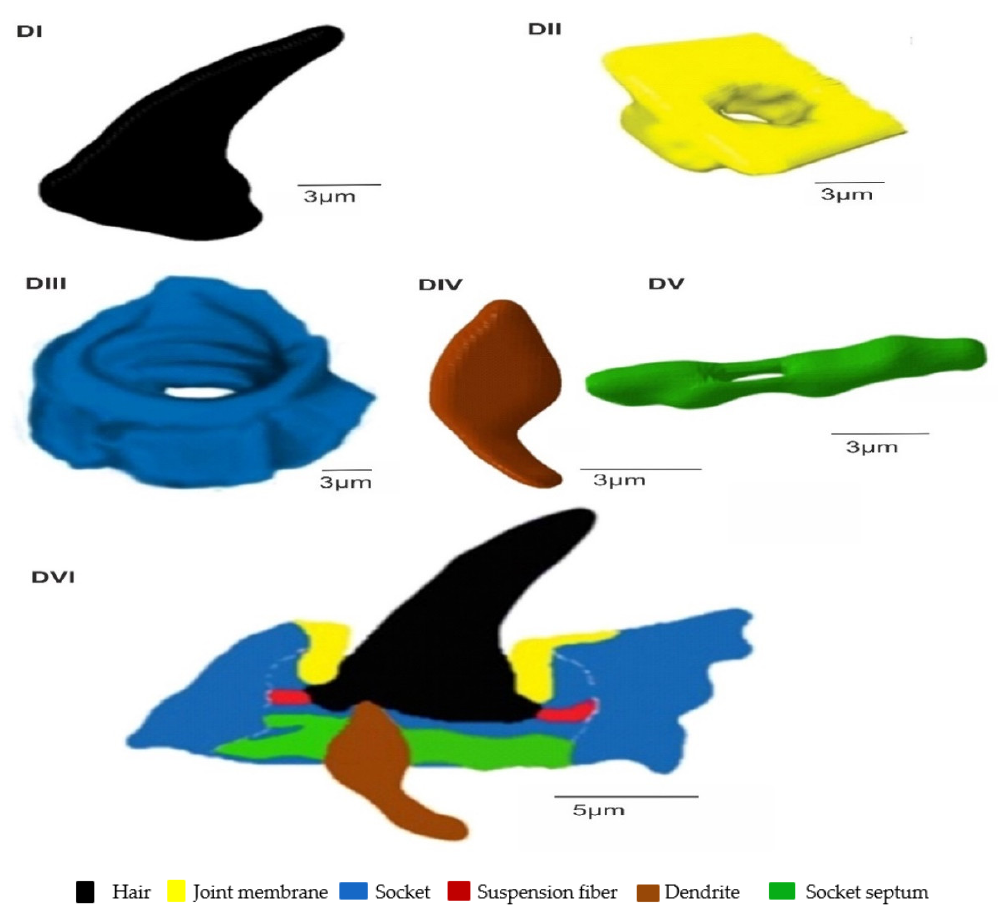
Figure 8. Three-dimensional model of trichoideum sensillum’s internal organizational structure, developed by Amira software. Individual components are ( DI ) hair; ( DII ) joint membrane; ( DIII ) socket; ( DIV ) dendrite; ( DV ) socket septum. ( DVI ) Sectional view model of the sensillum.